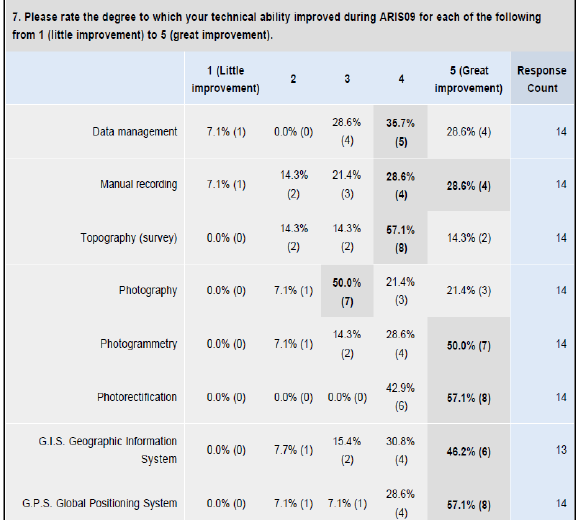
Figure 5. Evaluation sample from the ICCROM-GCI training course ARIS